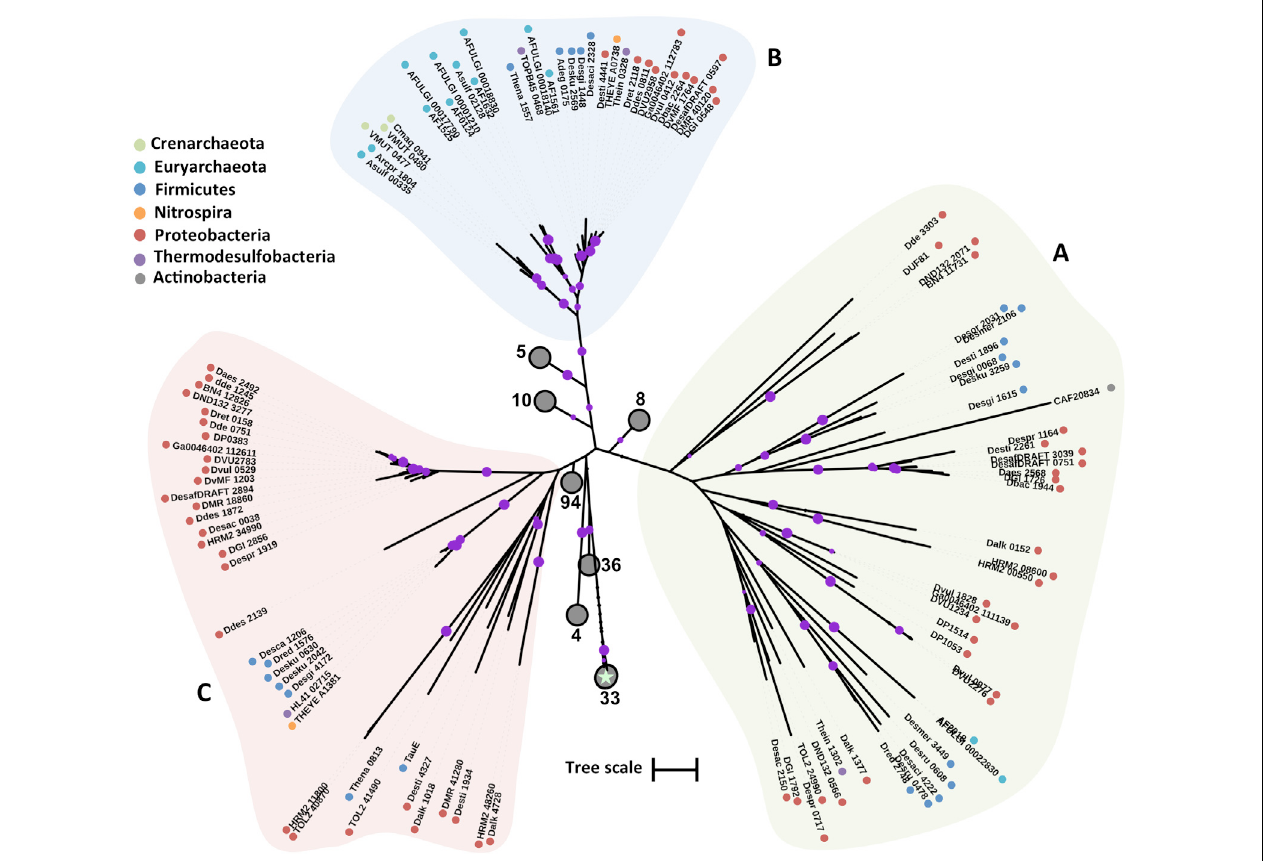
FIGURE 7 | Maximum likelihood phylogenetic tree of CysZ protein sequences. The different protein clades are marked with different colored backgrounds and given a letter label (A–C) . Phylum level classification of the protein sequences is indicated by colored dots next to the accession number (see Supplementary Table 1 for organism information). Collapsed nodes are presented as gray circles, the number of collapsed leaves is indicated next to the circle. The E. coli CysZ sequence is indicated on the tree by a star. Reference sequences: DUF81, probable sulfite/organosulfonate exporter (UniProt Q0K020), CAF20834 (CysZ sulfate transporter in C. glutamicum ), TauE, probable sulfite/organosulfonate exporter (UniProt K7WU96). Bootstrap values ≥ 50% are indicated by purple dots on each branch where the size of the dot is proportional to the value. The scale bar represents 1 substitution per amino acid